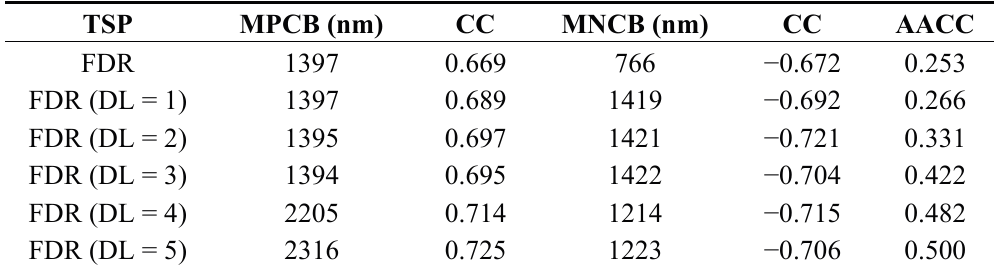
Table 4. Correlation analysis between total soil nitrogen (TN) and the first derivative differential FDR (initial and decomposed).